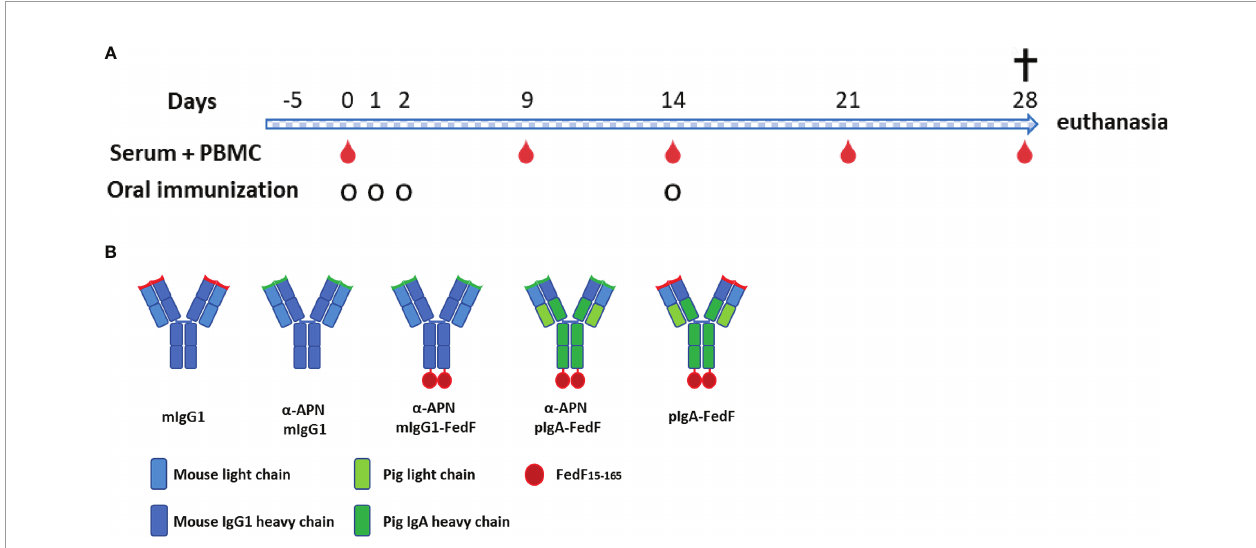
FIGURE 5 | Experimental overview. (A) Timeline of oral immunization experiment with serum and PBMC collection days and oral immunization time points. (B) Overview of different antibody constructs. mIgG1, mouse IgG1; plgA, pig lgA.